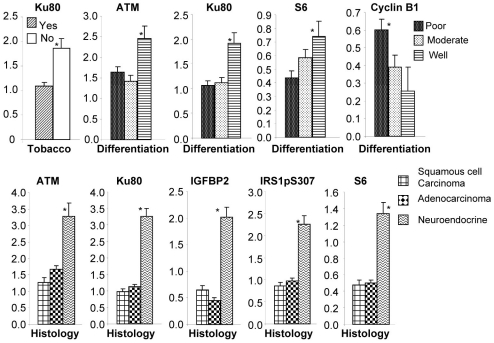
Protein levels in tumor tissues and association with clinical parameters.Protein levels in tumor tissues detected in RPPA assay were analyzed for associations with clinical parameters of patients. The molecule that was significantly different in tumors based on clinical parameters analyzed is shown on the top of each graph. The clinical parameters are shown at the bottom of each graph. The histology and differentiation diagnoses were based on pathological reports in clinical database. * indicates that the difference was significant when compared with other groups in the same graph (p<0.05).